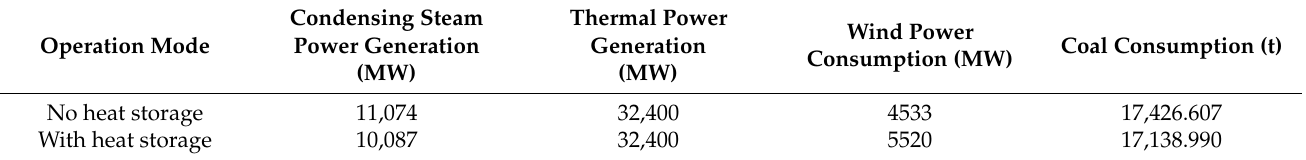
Table 8. Comparison of various power generation methods.